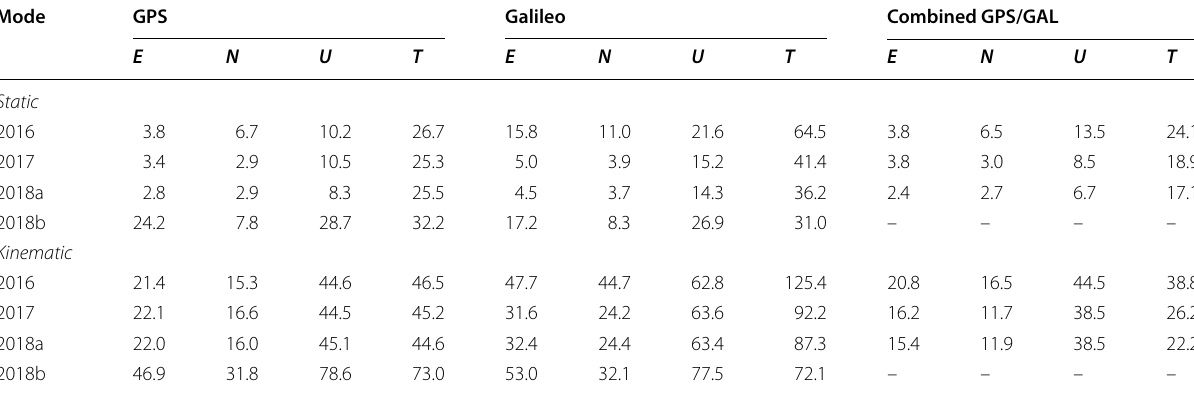
2018a and 2018b denote daily solutions based on the entire constellation and 3-h solutions based on 7 average visible satellites, respectively (unit: mm for ENU ; min for T )